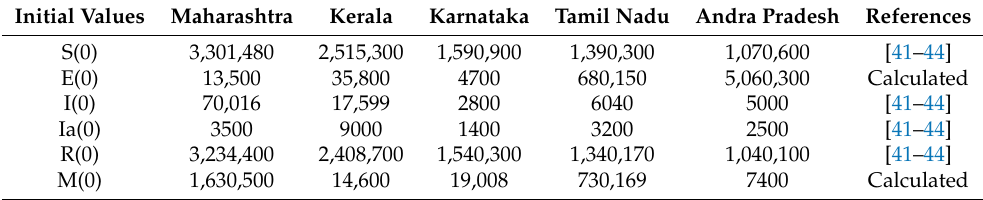
Table 6. Initial Values of parameters in the states of Maharashtra,Kerala, Karnataka, Tamil Nadu and Andhra Pradesh.